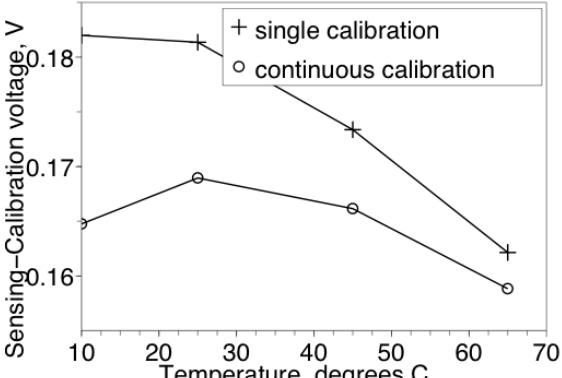
Figure 6. Temperature dependence of the sensor output at RH = 50%. Single-calibration curve shifted 10 mV for clarity.